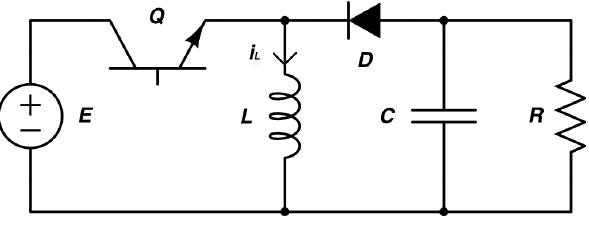
Figure 7. Buck-boost converter diagram.